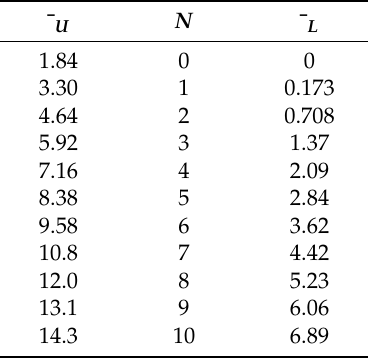
Table A1. Lower and upper ± 1.0 standard deviation confidence intervals for a Poisson variable